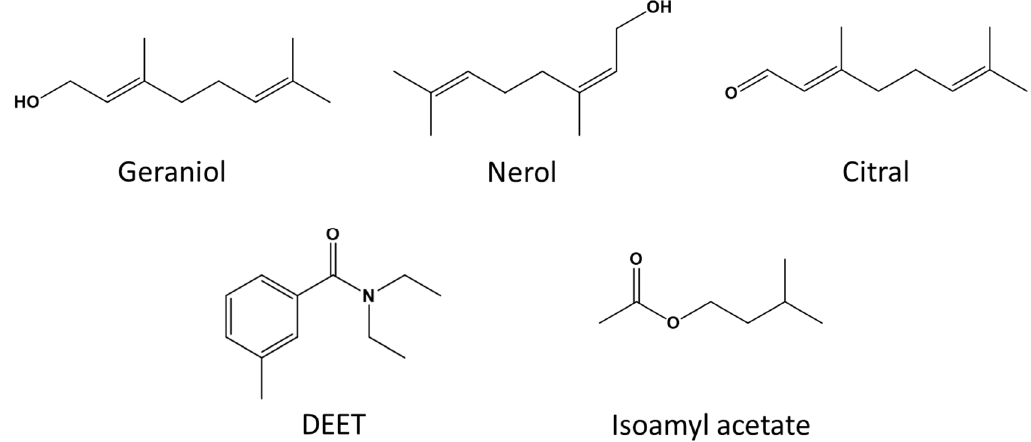
Figure 1. Chemical structures for the Nasonov terpenoids (geraniol, nerol, and citral), N,N -diethyl-meta-toluamide (DEET), and isoamyl acetate.